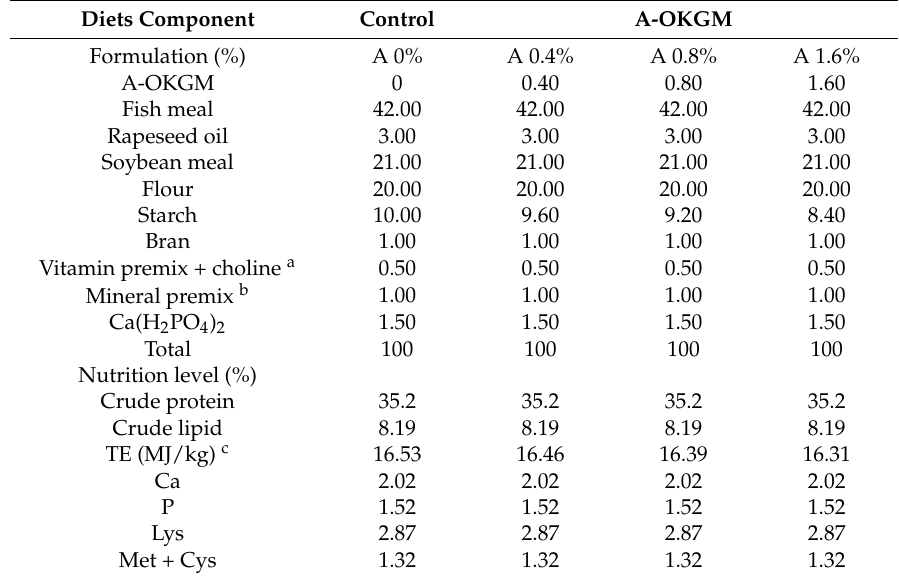
Table 2. Formulation of experimental